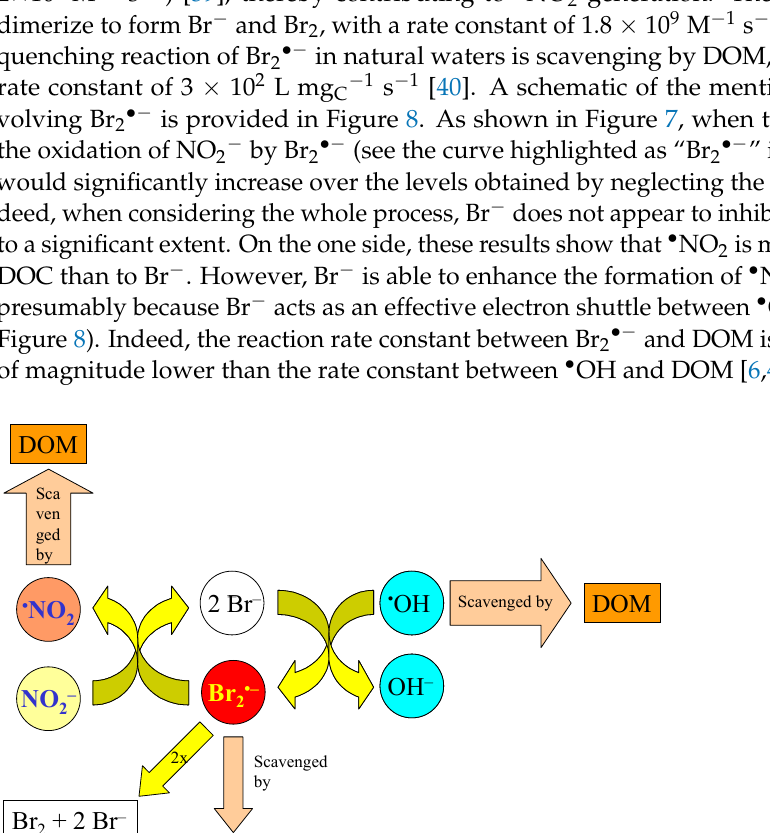
Figure 9. Pseudo-first order rate constants of the GSH’s indirect phototransformation, as a function of ( a ) the DOC, and ( b ) the bromide concentration. Other conditions (when the given parameter is not set to vary on the X-axis): 5 m water depth, 0.1 mM NO 3 − , 1 µM NO 2 − , 1 mM HCO 3 − , 10 µM CO 32- , 1 mg C L − 1 DOC, negligible Br − , and 22 W m − 2 sunlight UV irradiance (equivalent to fair weather, 45°N latitude 15 July, at 9 a.m. or 3 p.m.). The color code depicts the relative importance of the different phototransformation processes.